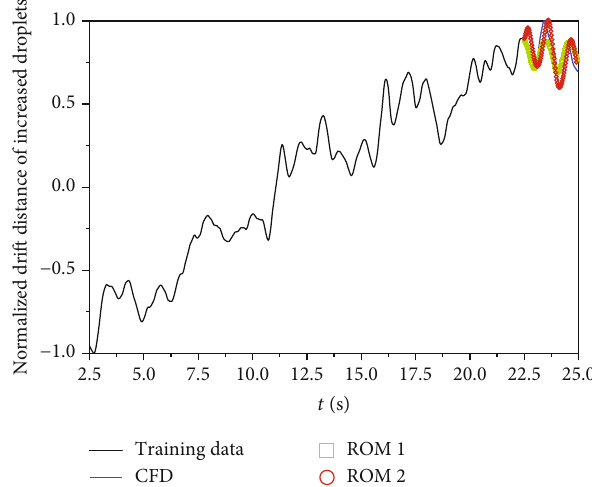
Figure 20: The training and prediction for the drift distance of increased